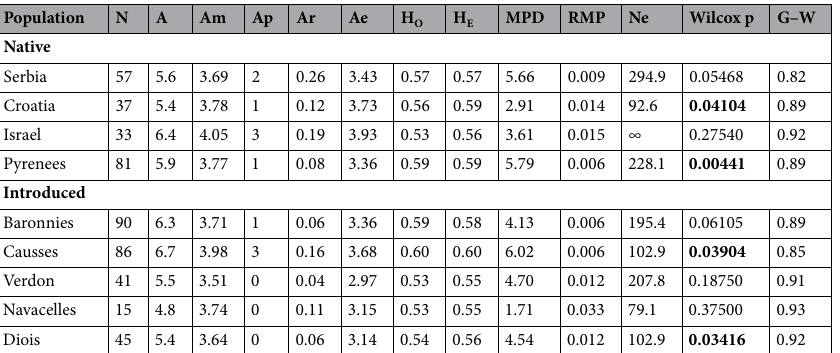
Table 1. Genetic diversity parameters, effective population size, Wilcoxon signed-rank test, and Garza– Williamson index determined per native and introduced populations of G. fulvus . Mean values are presented. N, number of genotyped individuals, A, mean number of alleles, Am, number of alleles based on a minimal sample size of 12 diploid individuals, Ap, number of private alleles detected in the population, Ar, number of private alleles based on a sample of 12 diploid individuals, Ae, mean effective number of alleles, H O , observed heterozygosity, H E , expected heterozygosity, MPD, mean number of pairwise differences, RMP, random match probability, Ne, effective population size, Wilcox. p , p value corrected by sequential Bonferroni test obtained by the Wilcoxon signed-rank test ( p < 0.05, the significant p value is bolded), G–W Garza–Williamson index.